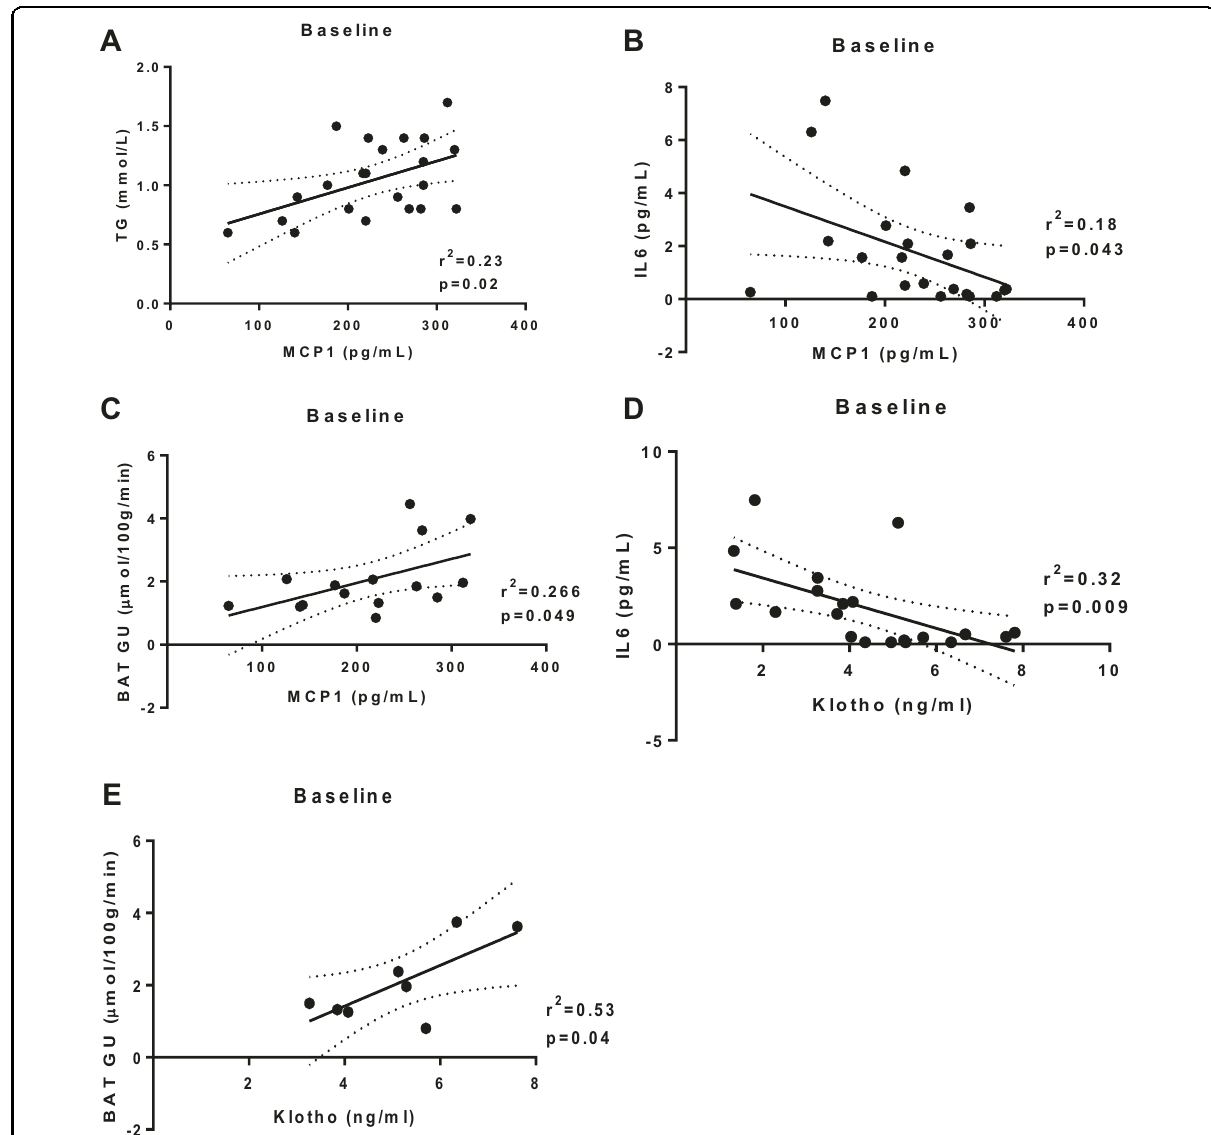
Fig. 2 Correlations between baseline measurements of MCP-1 and Klotho and baseline metabolic parameters. Pearson ’ s correlations between baseline concentrations of MCP-1 ( a – c ) in both training groups with triglycerides ( a ), BAT glucose uptake ( b ) and IL-6 concentrations ( c ), and Klotho concentrations ( d – e ) with IL-6 concentrations ( d ) and BAT glucose uptake ( e ). N = 9 –